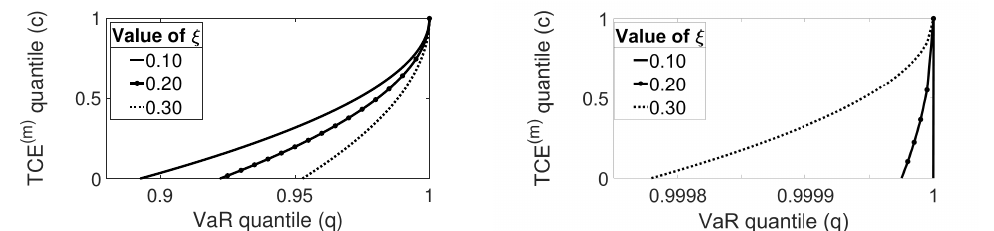
Figure 2. Extended TCE quantile as a function of VaR quantile. ( Left panel ): m = 2 and θ = 1. ( Right panel ): m = 2 and θ = 5.